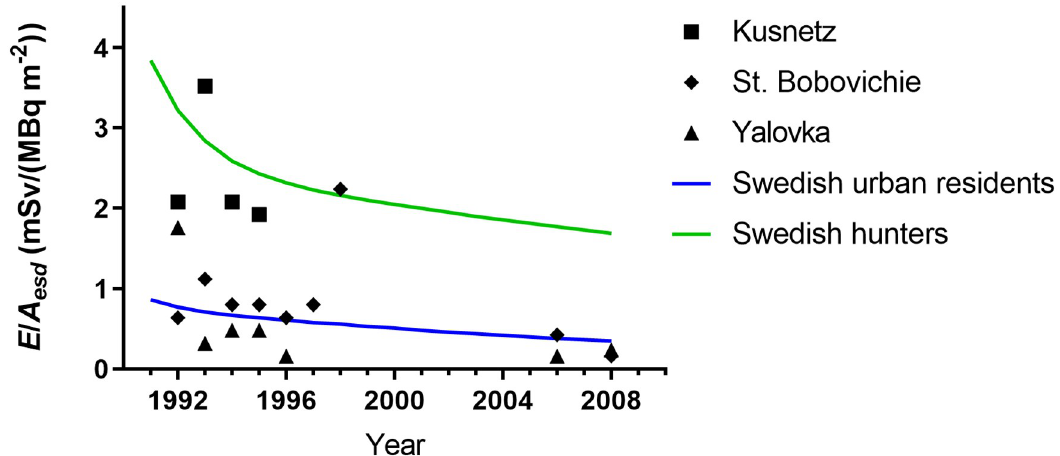
Fig 10. Yearly effective dose, E , per unit areal activity deposition of 137 Cs, A residents and hunters, together with estimates based on measurements performed in three Russian villages [28], [29].